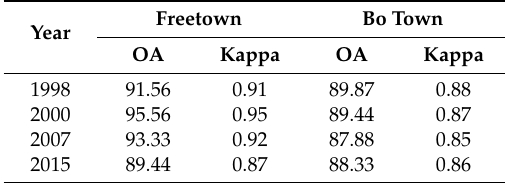
Table 1. Accuracy of multi-temporal LULC classifications in Freetown and Bo